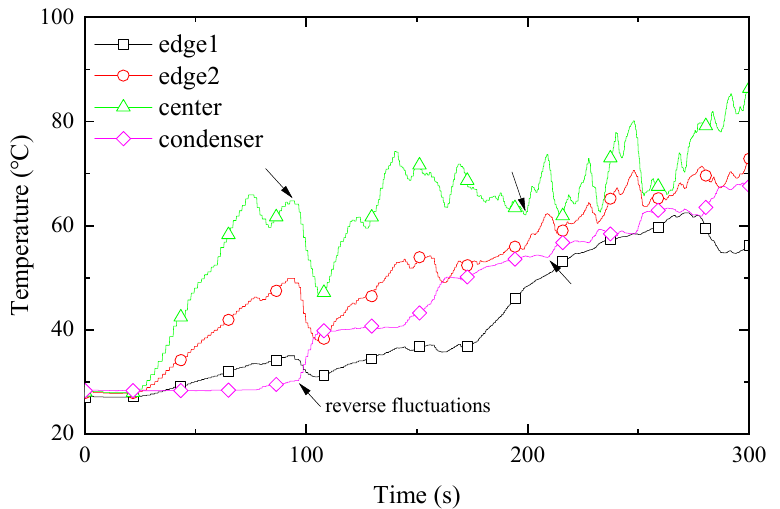
Figure 8. Temperature variations of the PHP filled with 0.5 wt% MWCNTs nanofluid with a filling ratio of 80%.